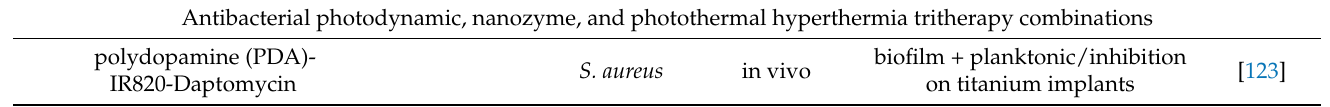
Table 4. Antibacterial photodynamic, nanozyme, and photothermal hyperthermia tritherapy combinations. Photodynamic, Nanozyme, and Photothermal Hyperthermia